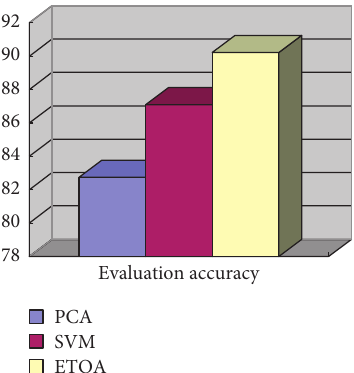
Figure 6: Performance comparison with other English teaching quality evaluation